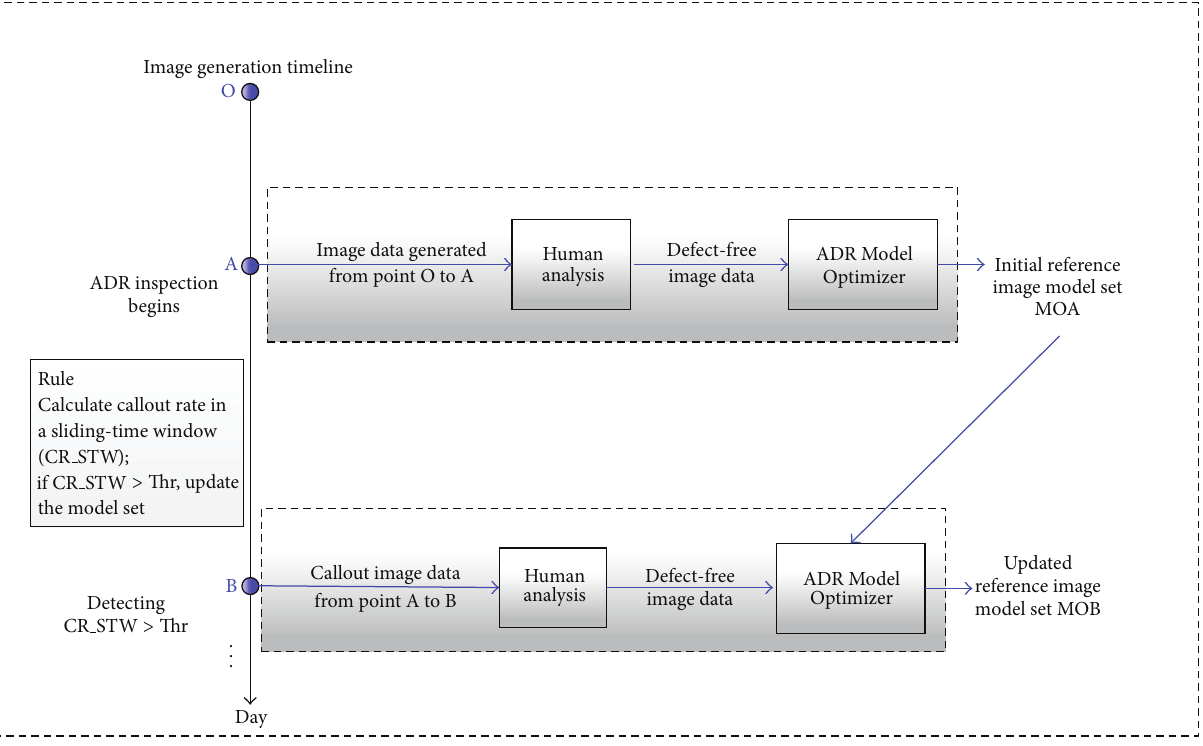
Figure 4: Framework of the proposed adaptive method to select the reference model image